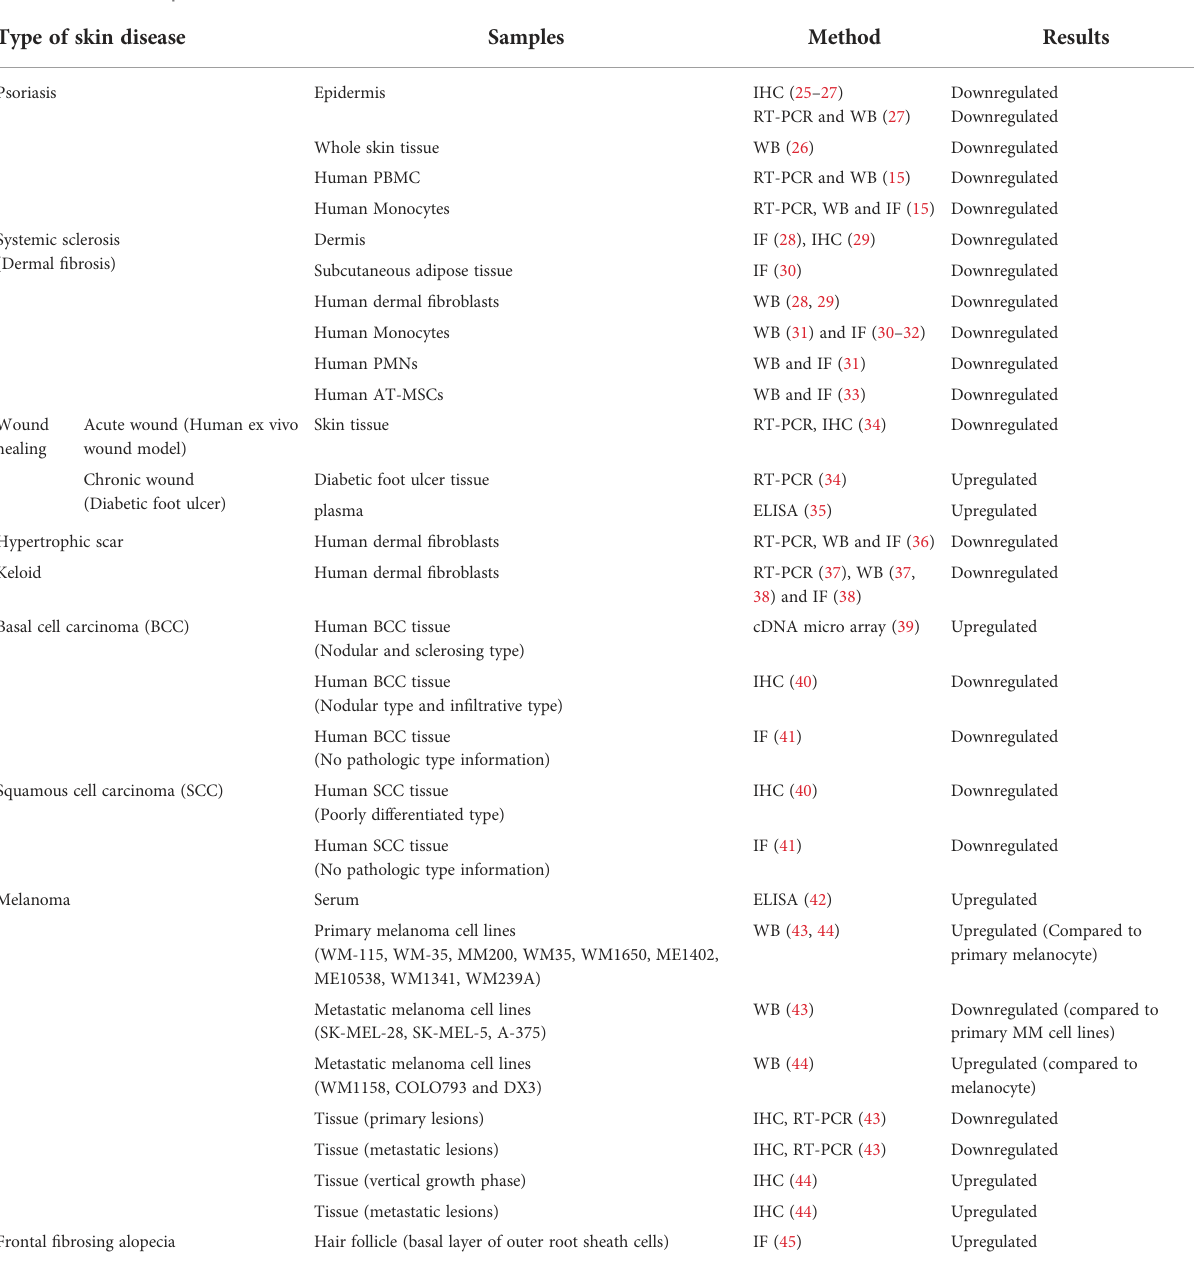
TABLE 1 Aberrant expressions of CAV-1 in human skin